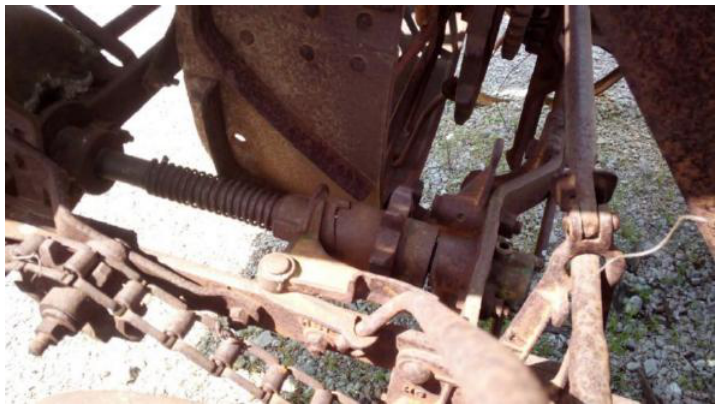
Figure 31. Clutch